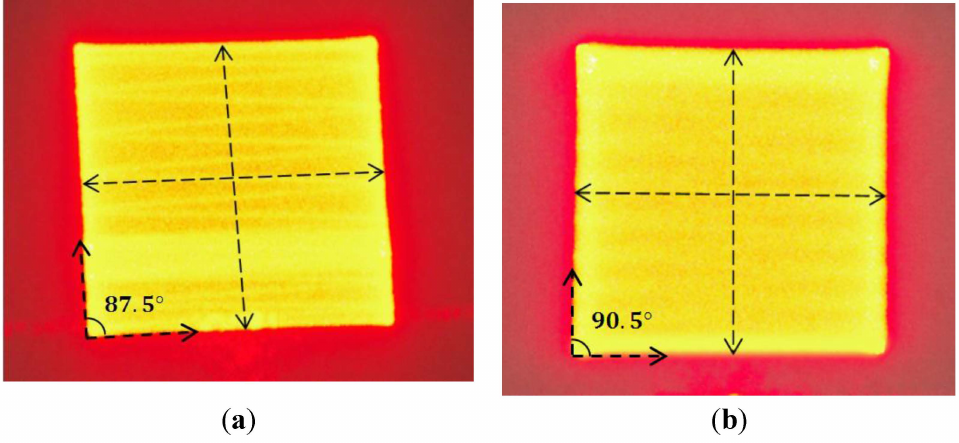
Figure 13. Roster scanning patterns on the screen: ( a ) generated by standard triangle signals; and ( b ) generated by the model-based signals.